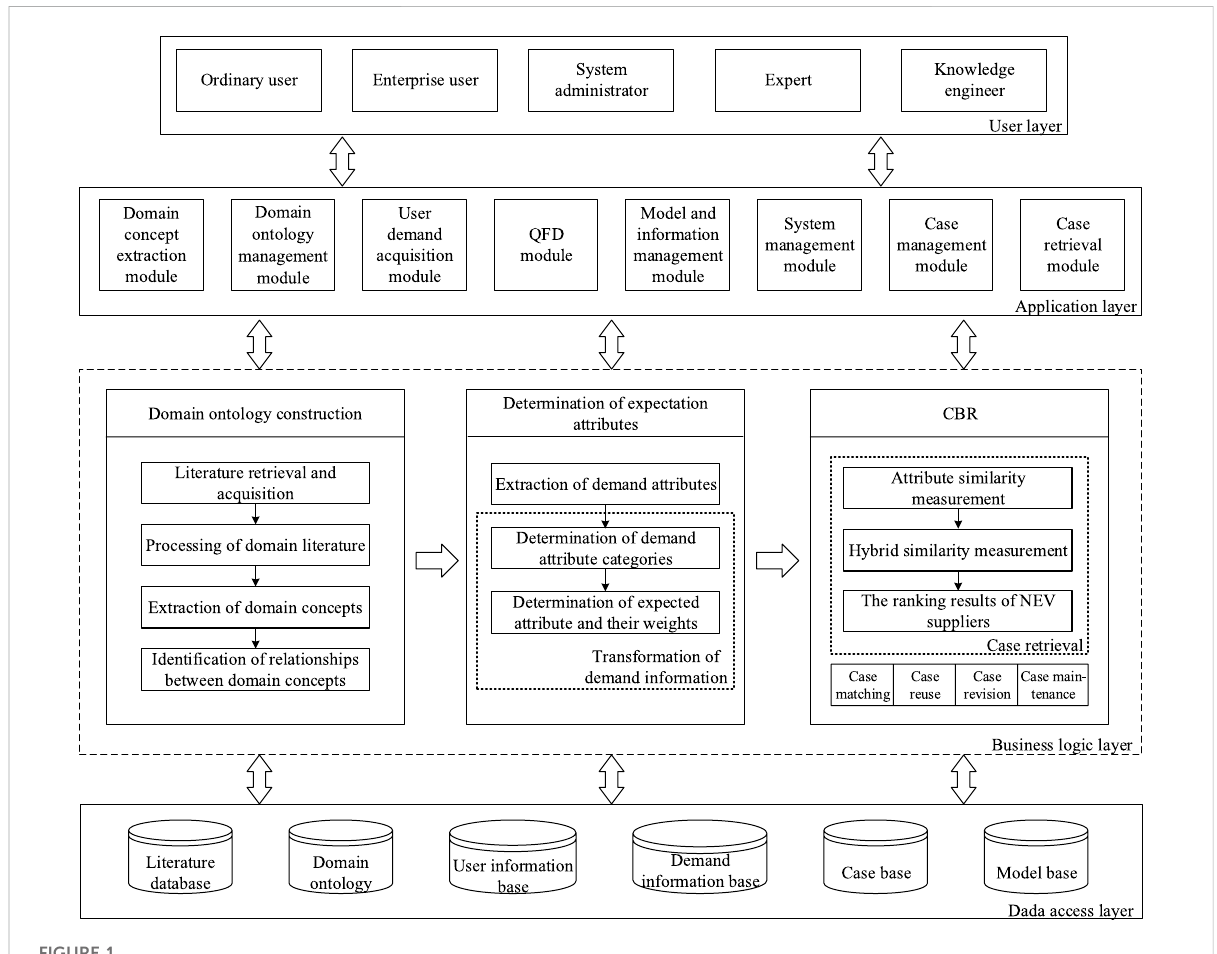
FIGURE 1 Architecture of the demand-driven NEV supplier selection